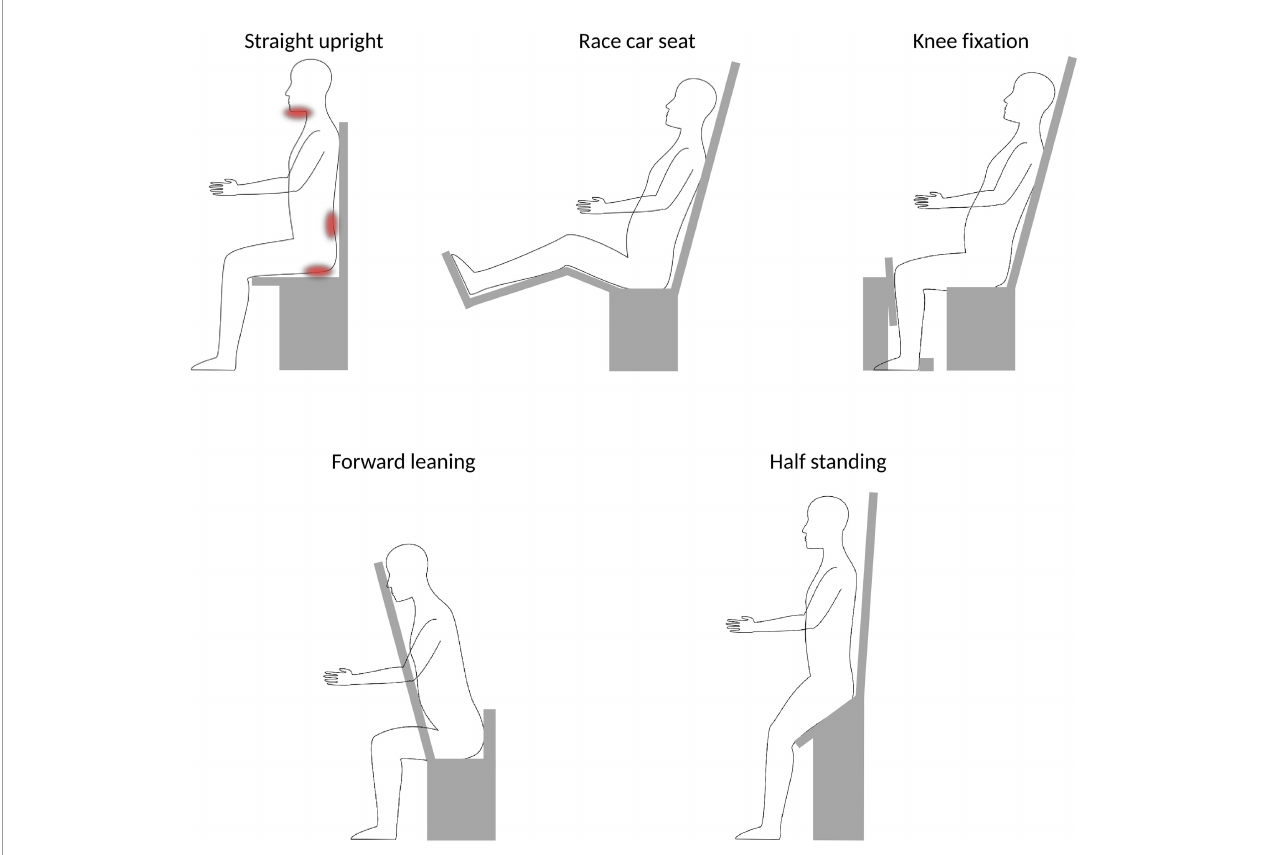
FIGURE 3 | Schematic overview over different postures. A straight upright posture [e.g (42)., and (31)] has been noted to induce stress on chin (for head&neck patients) and may be uncomfortable for long treatment duration, as indicated by the red areas. More ideal would be ~20° reclined position, where the forward push on the pelvis could be stabilized by a race-car seat posture [e.g (9)], or by adding a knee fi xation [e.g (8)] or a belt strap [e.g (35)]. Alternative postures could be forward leaning for head&neck or possibly spine irradiations [e.g (26)] or half-standing, enabling to image and treat sites below the thorax [e.g